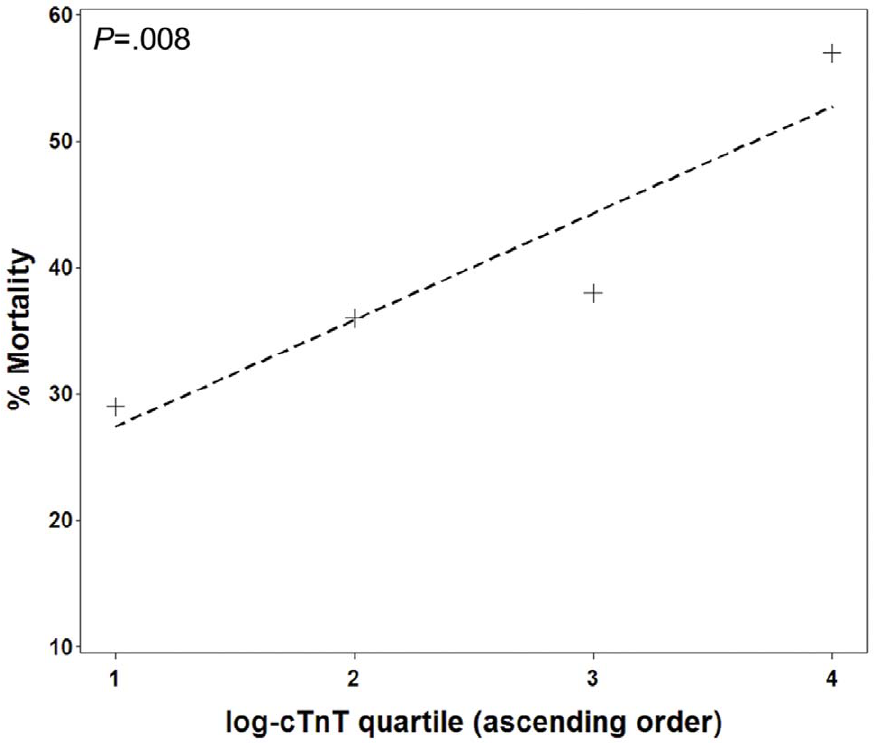
Figure 1. Relationship between cTnT log quartile and mortality, with superimposed trend line. ( P value stated for Cochran-Armitage test of trend).